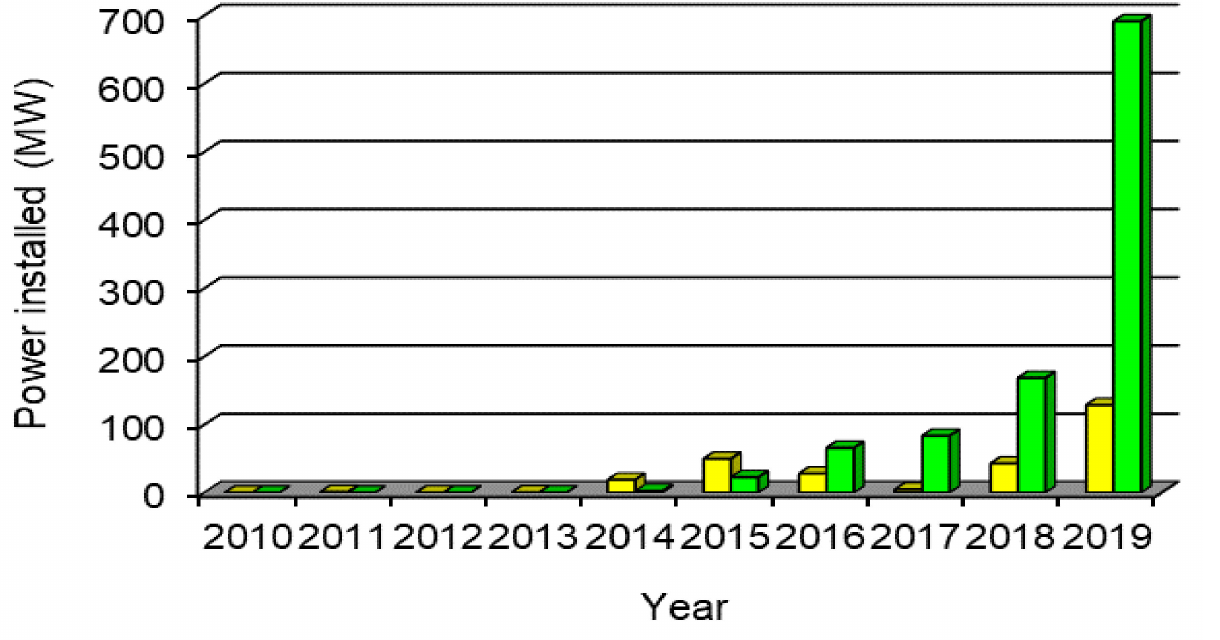
Figure 2. Power installed in a given year, light yellow colour–installations over 50 kW, green colour–micro installations. Own elaboration based on data from